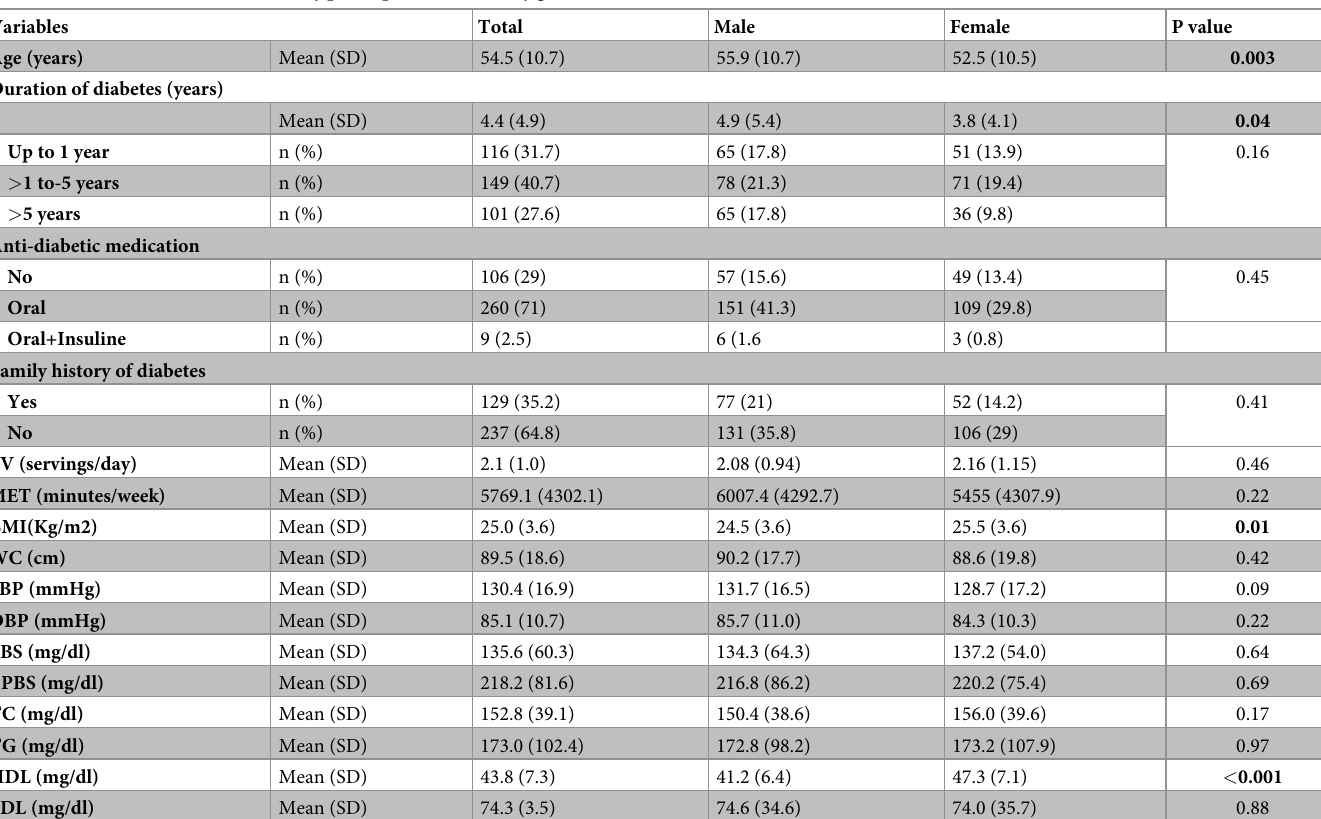
Table 2. Clinical characteristics of study participants stratified by gender (N =